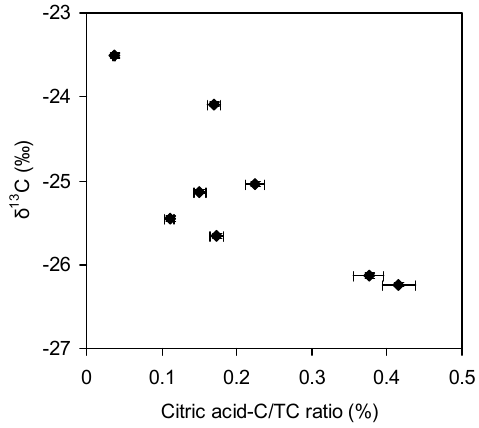
Fig. 10. δ 13 C TC values as a function of citric acid carbon (citric acid-C) to TC mass ratios during the pollen